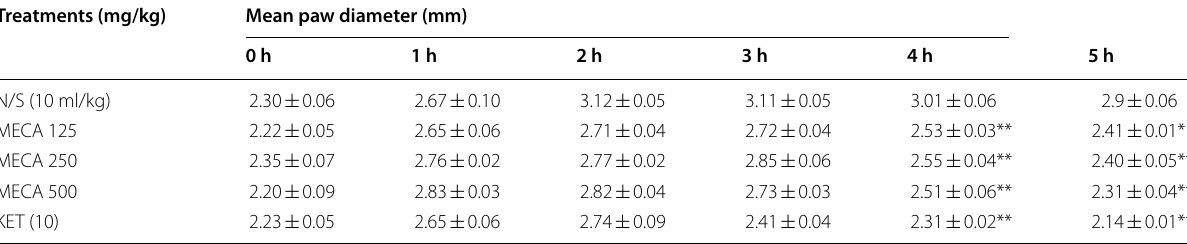
The values were analysed using repeated-measures ANOVA followed by Bonferroni post hoc test and presented as mean MECA, methanol leaf extract of Culcasia angolensis ; Ket, ketoprofen * p < 0.05, ** p < 0.001 significant decrease in mean paw oedema compared to time zero; n